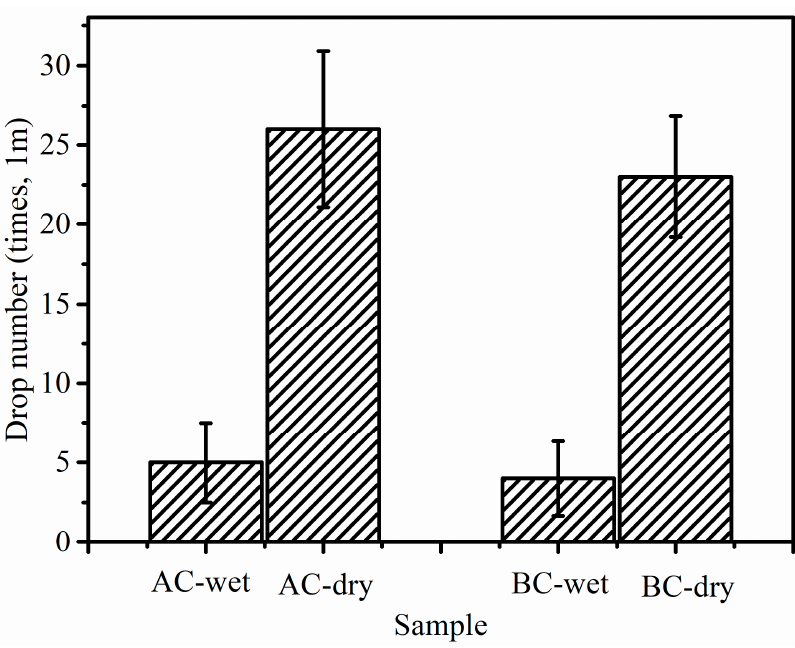
Materials 2021 , 14 , x FOR PEER REVIEW Figure 7. Dropping times of the wet and dry CBBs. Figure 7. Dropping times of the wet and dry CBBs.